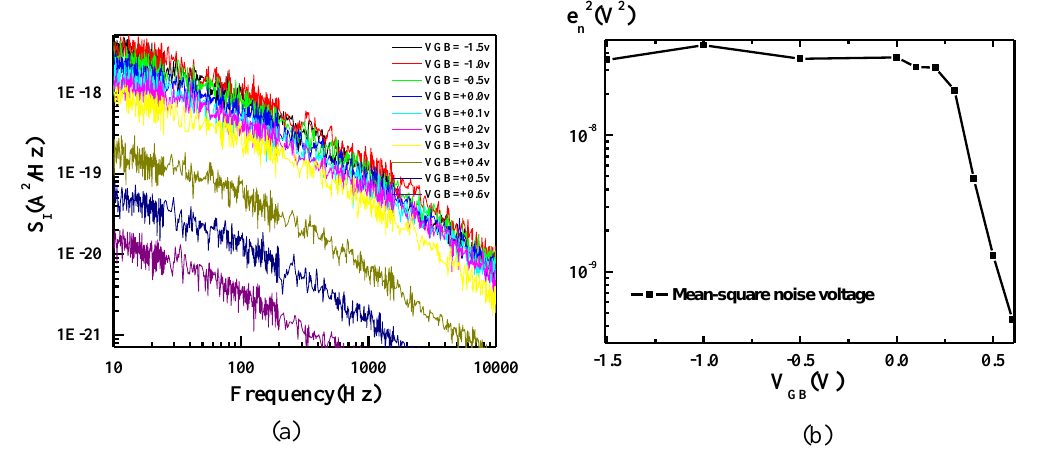
Figure 7. Noise measured with various V (a) noise power spectral density (b) mean-square noise voltage integrated from